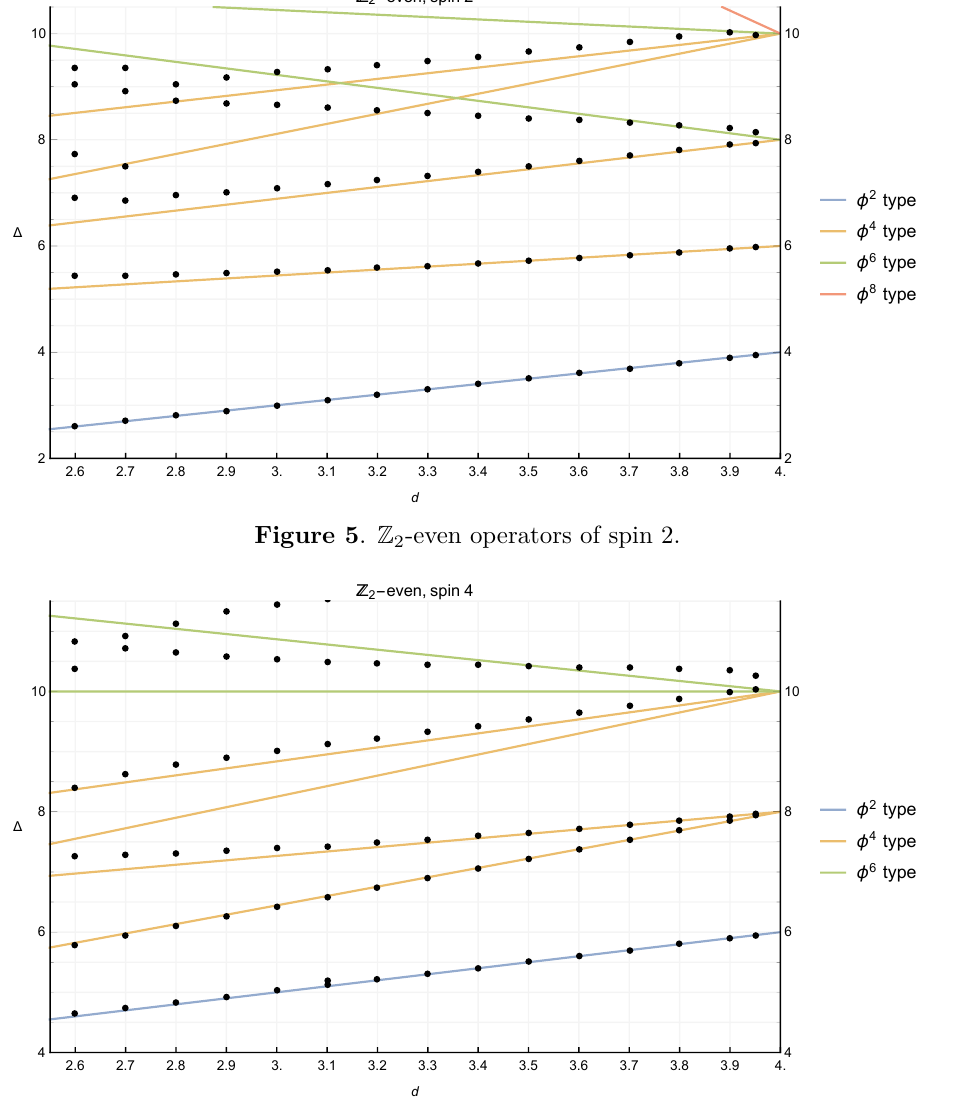
Figure 6 . Z 2 -even operators of spin